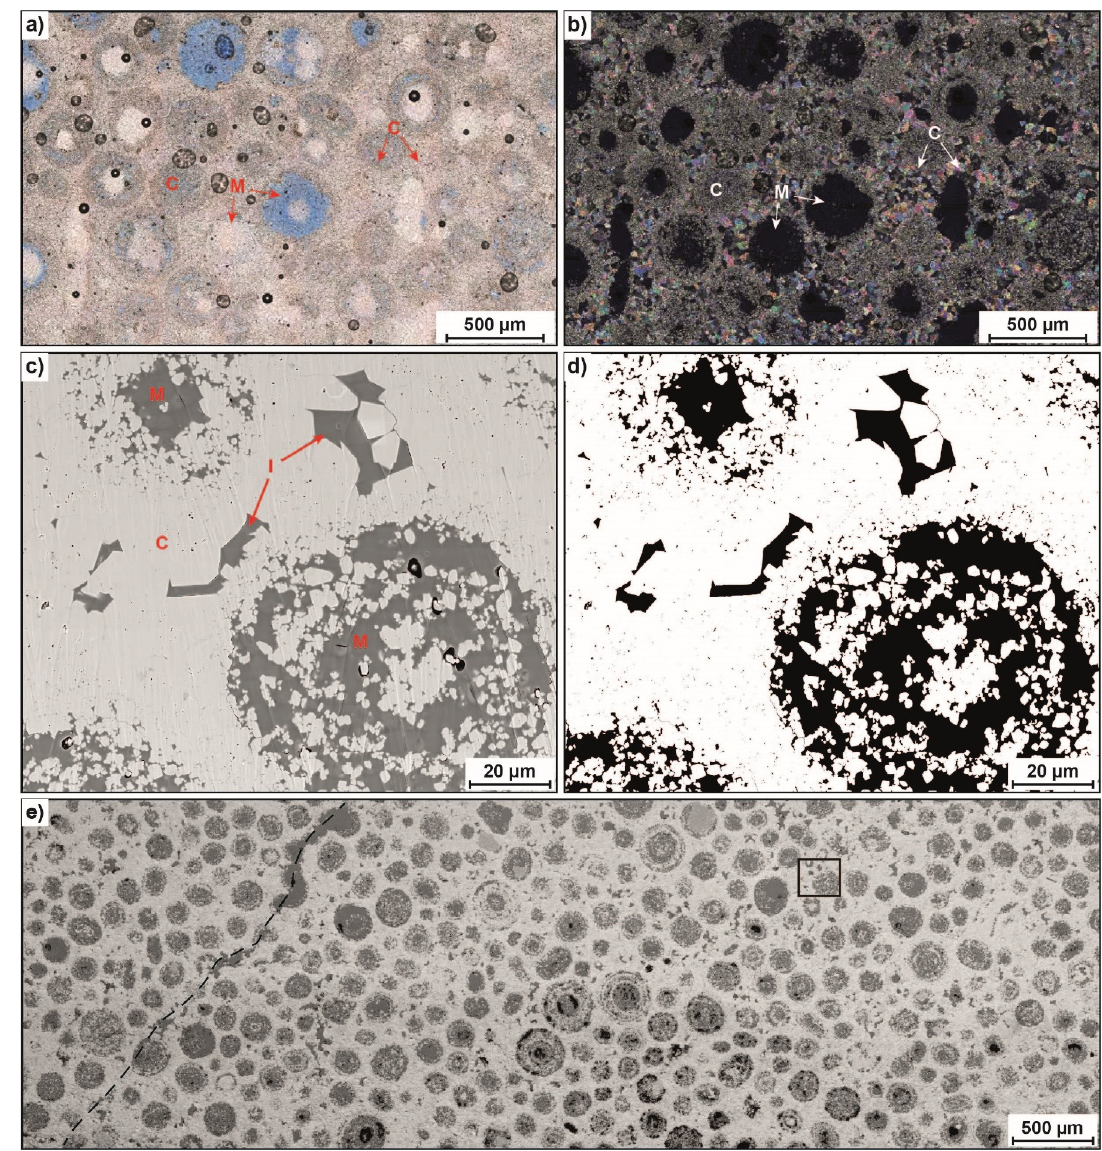
Figure 6. Petrographic observations of dolomitic-limestone oolitic-grainstone shoal samples 403 and 404. Thin-section images ( a ) (plane-polarized) and ( b ) (cross-polarized) of sample 403 show dissolved or partly dissolved ooids, i.e., moldic porosity (M), which are major contributors to total porosity. ( c ) High resolution mosaic within the BIB-polished area of sample 404 stitched from 467 images. Mostly tight calcite-cement mosaics (C) with only minor amounts of intercrystalline pores restrict the connectivity between moldic pores. ( d ) Binarized version of high-resolution image ( c ) used for image analysis (Figure 7d). ( e ) Large scale mosaic of sample 404 stitched from 190 images. The positions of detailed images ( c ) and ( d ) (black square) as well as a dissolution seam (black dashed line) are shown.